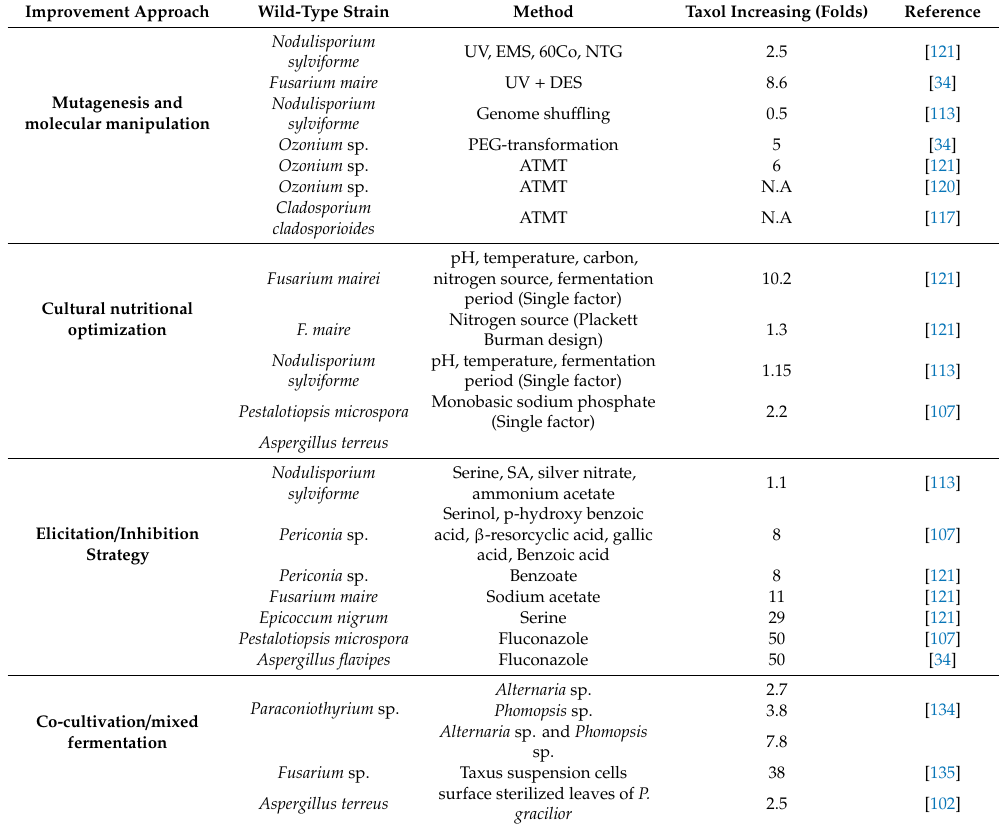
Table 2. Examples of strain fungal improvement approach and fungal endophyte strains with enhanced Taxol